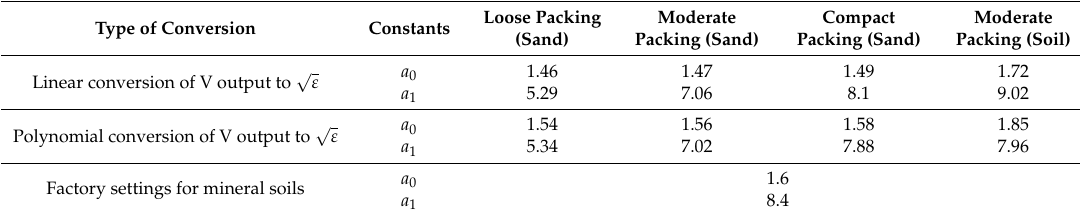
Table 2. Values of factory and own constants a 0 and a 1 for two-point ThetaProbe calibration equations for sand/soil materials.